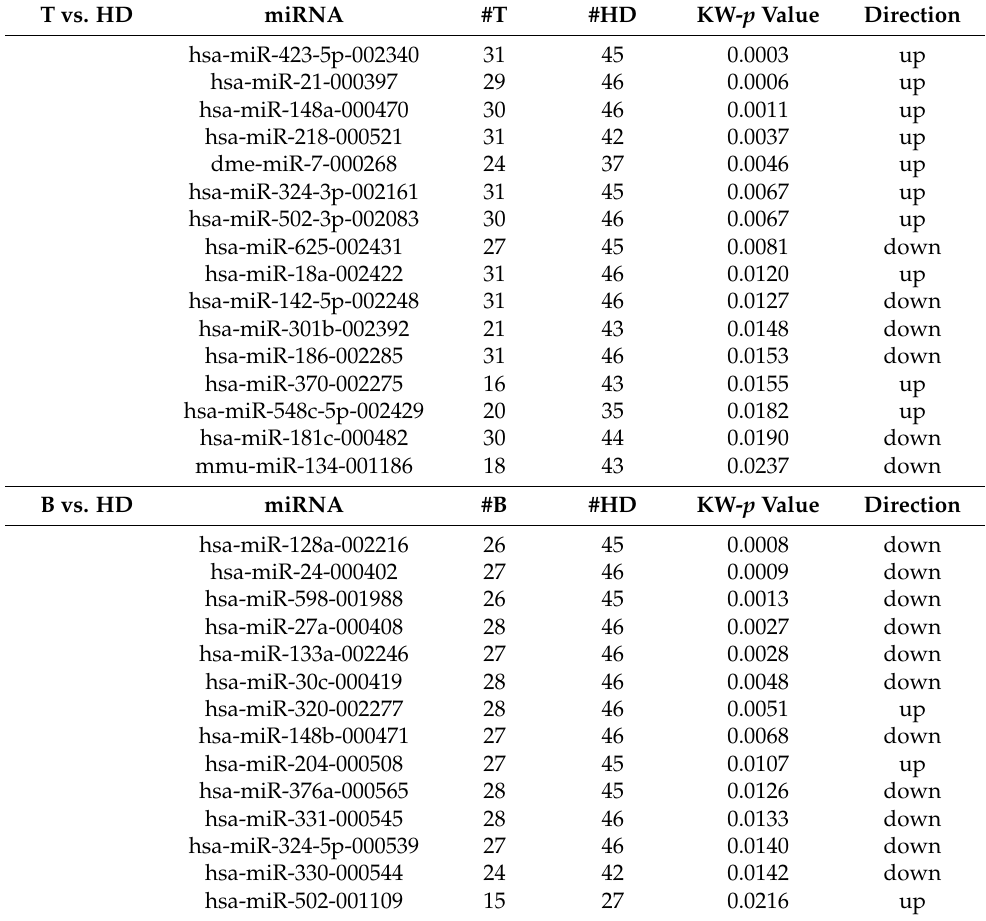
Table 2. List of differentially expressed miRNAs in the two disease-specific comparisons in the TRS. T vs.